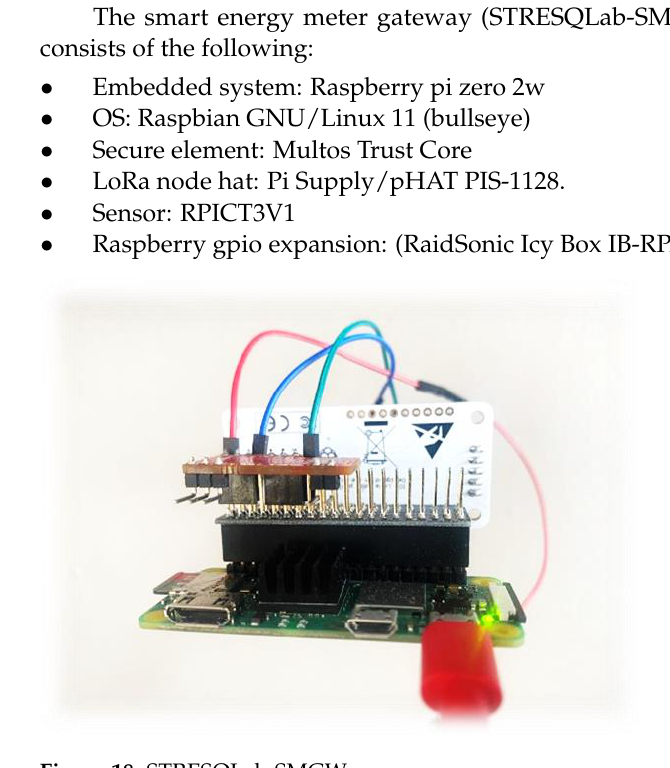
Figure 18. STRESQLab-SMGW. Figure 18.